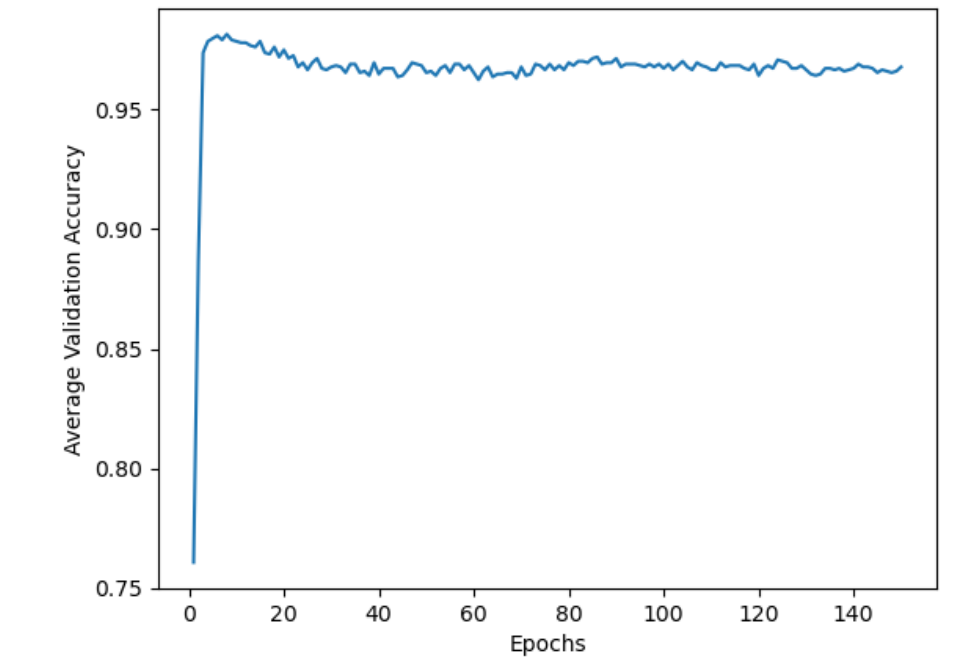
Figure 8. Average validation accuracy in 4-fold cross-validation experiment.